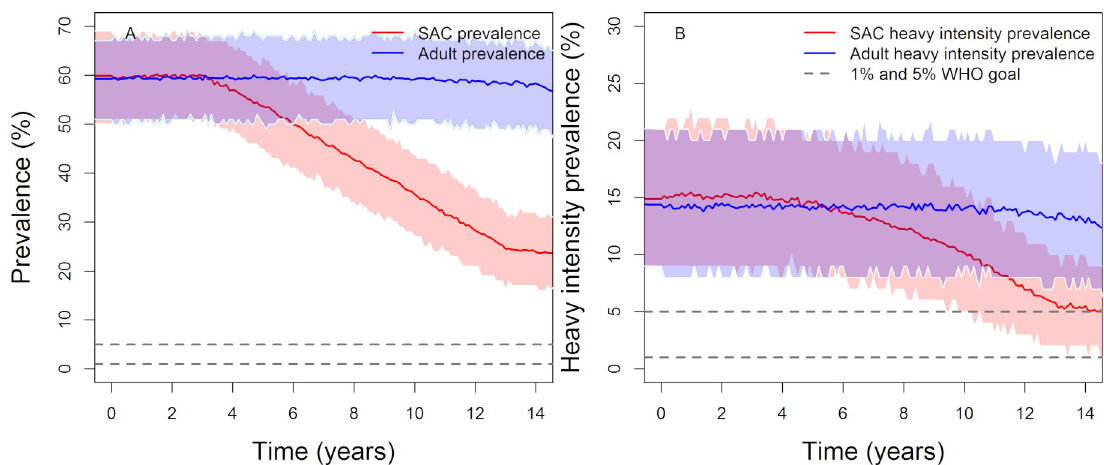
Fig 4. Model projections of annual vaccination of 85% of 1 year olds in high baseline transmission settings. Graph (A) shows the prevalence of infection, Graph (B) shows the prevalence of heavy-intensity infections, both in school-aged children (SAC) and adults. The average duration of vaccine protection is set at 20 years. Shaded areas (both blue and red) represent the 90% credible interval (90% of the simulated results fall within these shaded areas).